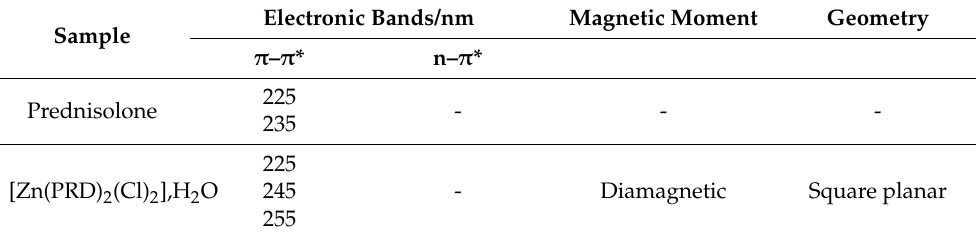
Table 1. Electronic spectra and magnetic moments of free ligand prednisolone, and its zinc